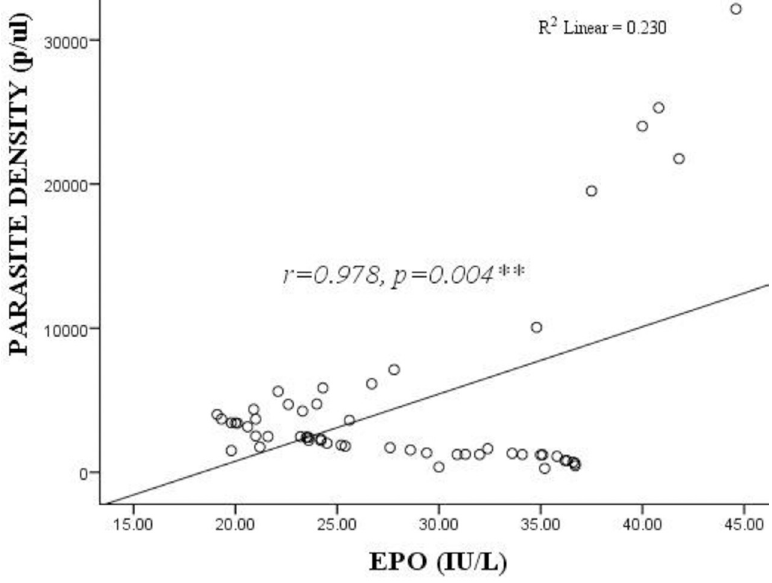
Fig 2. Association between serum erythropoietin levels and P . falciparum parasite density among pregnant women. ** Correlation was significant at 0.01 level, EPO = Erythropoietin. Spearman correlation. p < 0.05 considered statistically